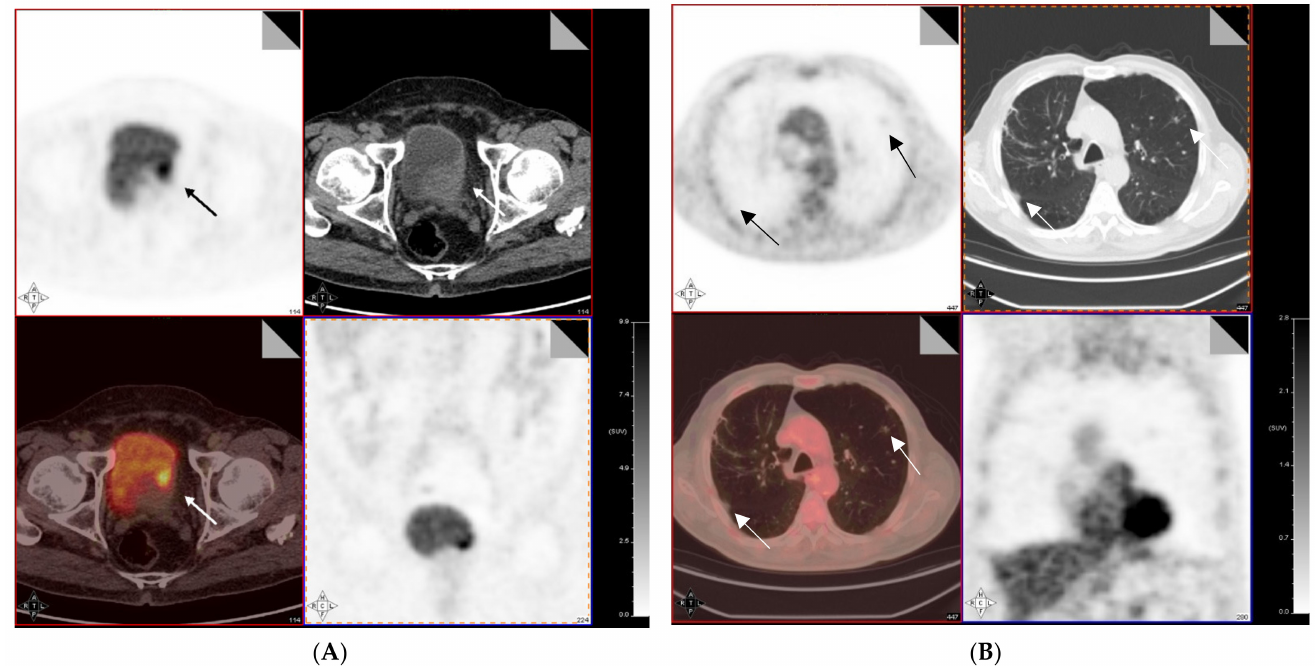
Figure 1. Transaxial FDG-PET with hydration (upper left), CT (upper right), fused (lower left), and MIP (lower right) of a patient with MIBC during staging before treatment. Focal intense FDG uptake on the left postero-lateral wall (solid arrow), without any other pathological uptake out of the bladder ( A ). In particular, small bilateral lung nodules did not show significant metabolism ( B ). The patient was submitted to cystectomy with wide lymphectomy, demonstrating pT4N0 MIBC. Lung nodules still persist as stable in the following TC.